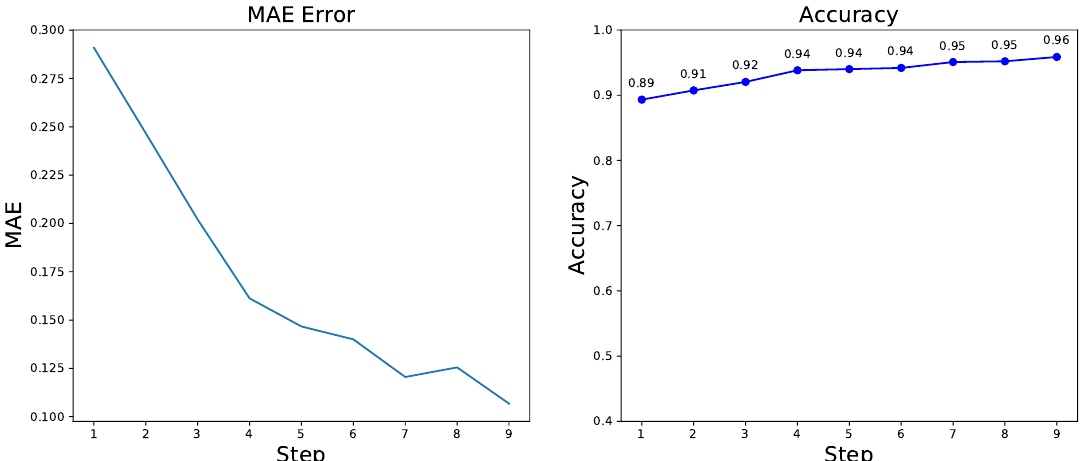
Figure 9. Mean Absolute Error (MAE) and classification Accuracy for SNR values from sensors 2 from Gateway